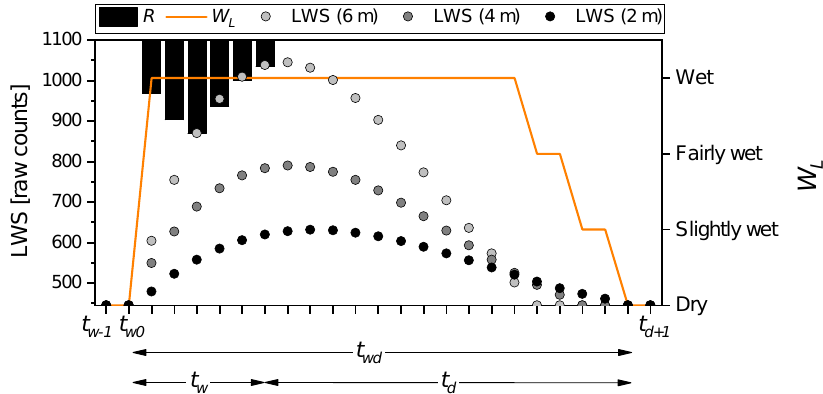
Figure 3. Conceptual translation of half-hourly LWS data to a canopy wetness level ( W L ) during a wetting–drying event ( t wd ). Wetting phase ( t w ) is when the rain ( R ) > 0 mm and drying phase ( t d ) is when the rain has ceased but the canopy is not fully dry. t w − 1 is 30 min before a wetting phase, t w 0 is the starting point of a wetting phase, and t d + 1 is 30 min after the end of a drying phase. The circles illustrate the evolution of canopy wetness at different heights above